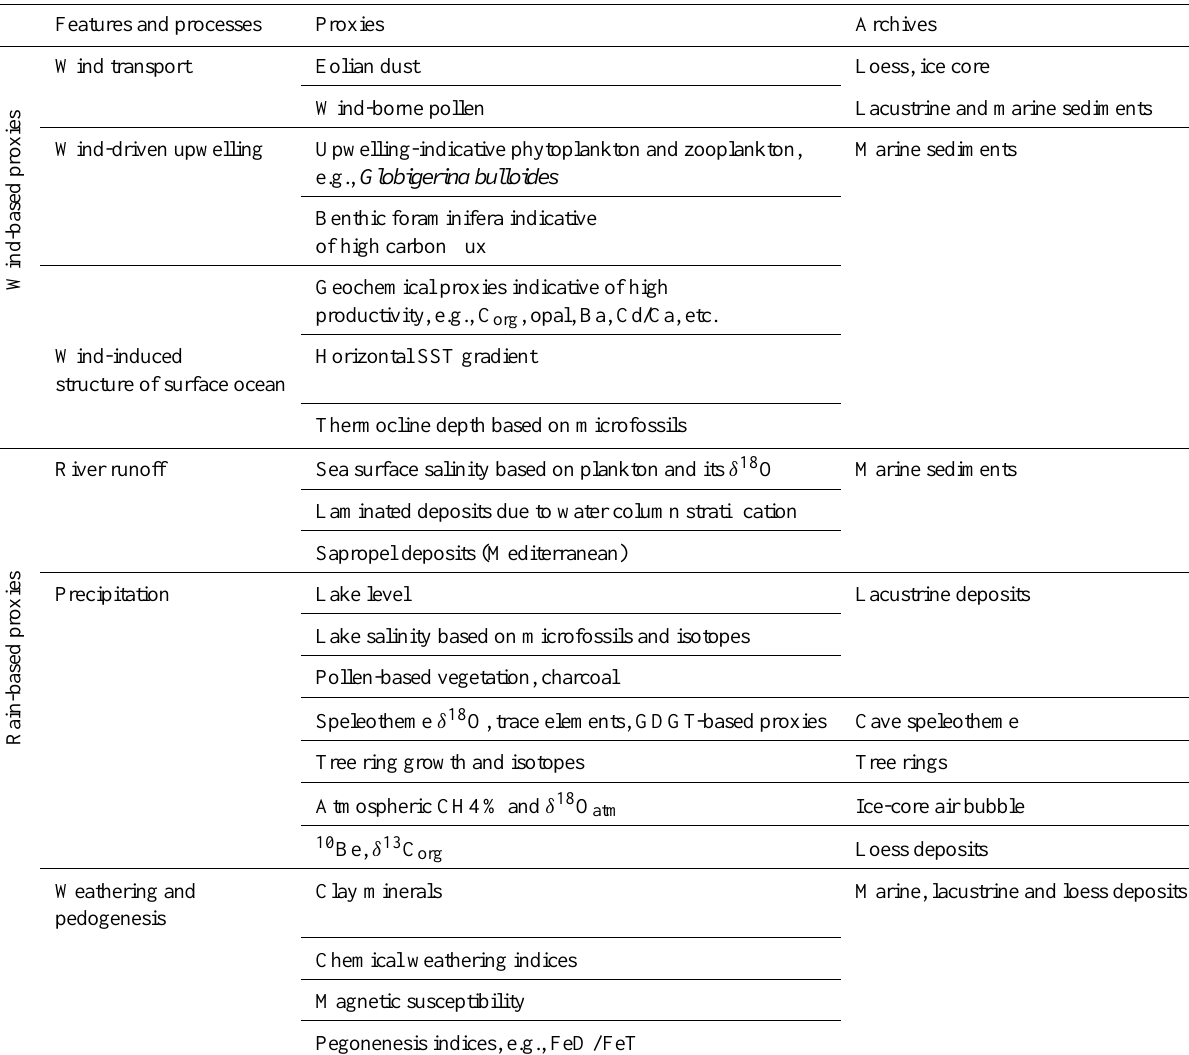
Table 1. A simplified overview of frequently used monsoon proxies. Features and